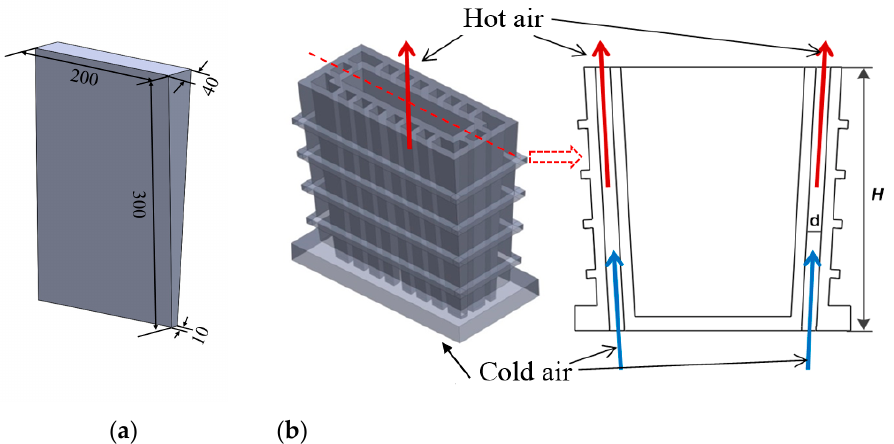
Figure 4. Schematic of the wedge-shaped plate casting and its sand mold with the chimney. ( a ) Wedge-shaped plate casting and ( b ) sand mold with the chimney (unit: mm).